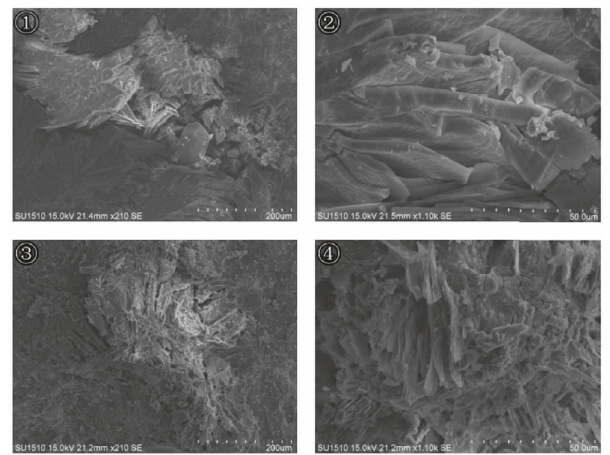
Figure7:SEMphotoofunsinteredsamples(HLWpH=5, AB Fe 2 O 3 free, CD 9% Fe 2 O 3 addition).